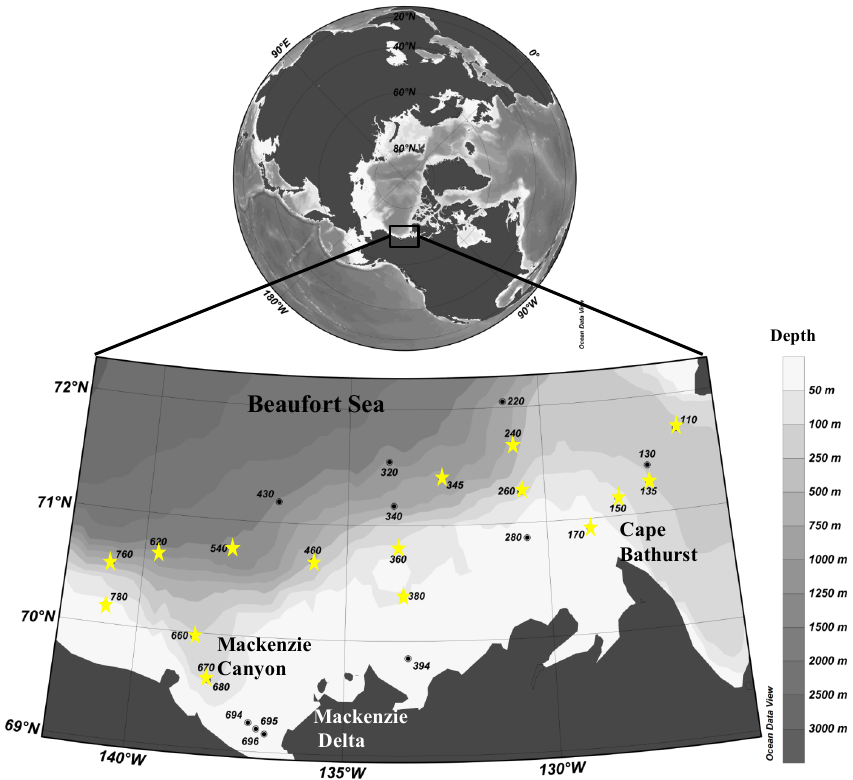
Fig. 1. Locations and station numbers investigated during the MALINA cruise over the Canadian shelf of the Beaufort Sea. Yellow stars Figure 1. Location and station number investigated during the MALINA cruise in the 710 represent the stations where profiles of downward irradiance were Canadian Shelf of the Beaufort Sea. Yellow stars represent the stations where profiles of 711 downward irradiance were performed. 712